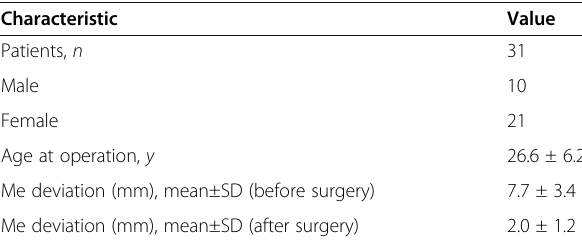
Table 1 Demographic and radiographic data of patients in the